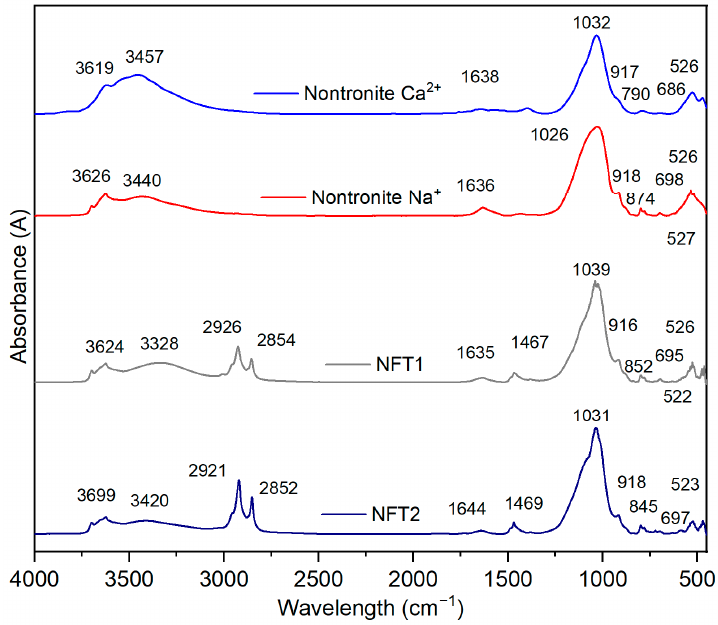
Figure 10. FTIR of treated and non-treated clays. Table 4. Position (cm − 1 ) and assignments of the prominent bands of the modified and unmodified clays [25,26].